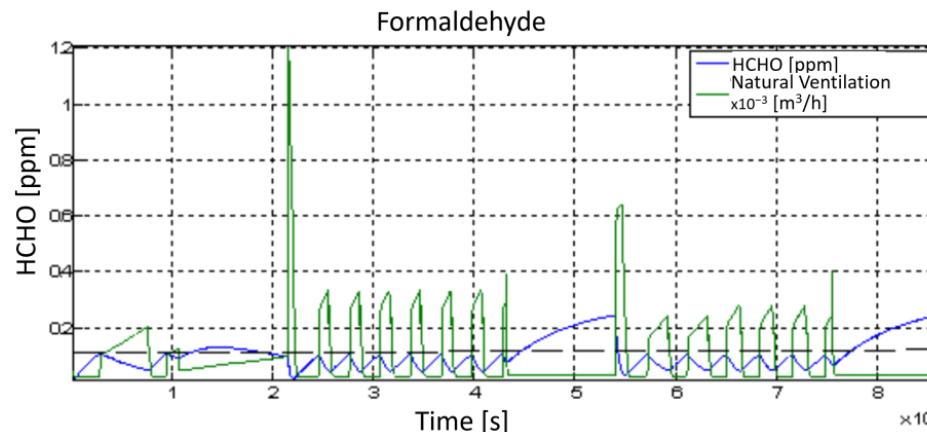
Figure 22. Control results: IAQ control, CO 2 (CV).